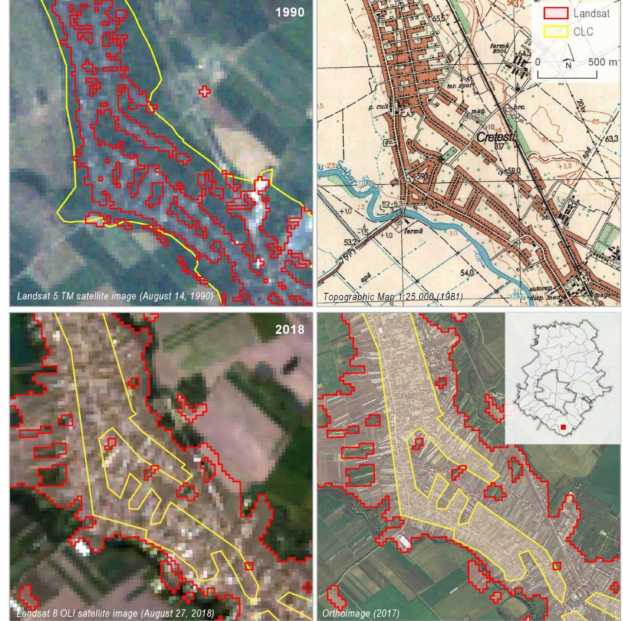
Figure 9. Comparative mapping of the change in the built-up (1990 / 2018) in the southeastern edge of Bucharest. Landsat TM (1990) and OLI (2018) imagery from USGS, topographic map (1981) from the DTM (Military Topographical Directorate) and aerial orthophotos (2017) by ANCPI (National Agency of Cadastre and Land